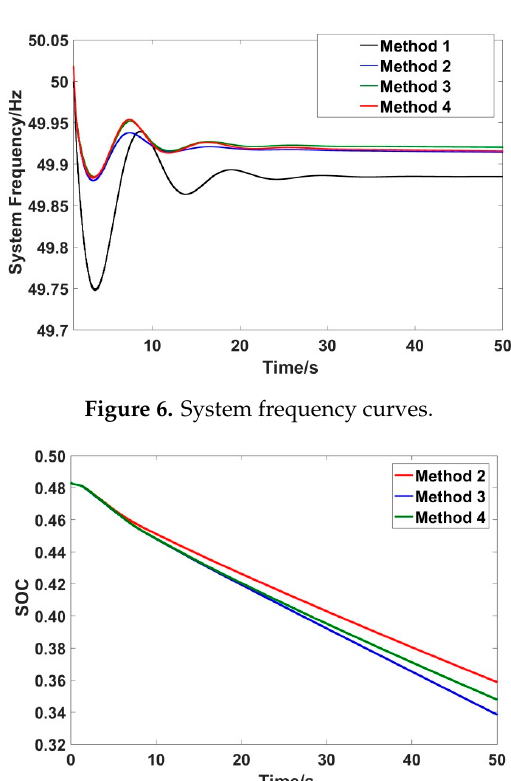
Figure 5. Schematic diagram of the simulation system.